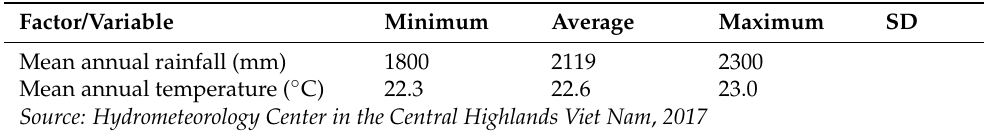
Table 1. Summary of selected variables at the sample plot locations and summary statistics for variables of destructively sampled bamboo culm.